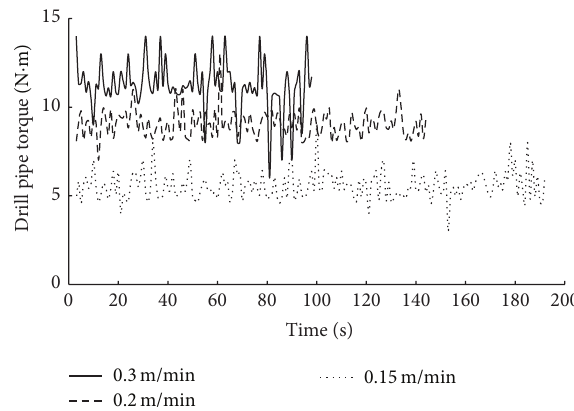
Figure 8: History time curve of drill pipe torque under different drilling